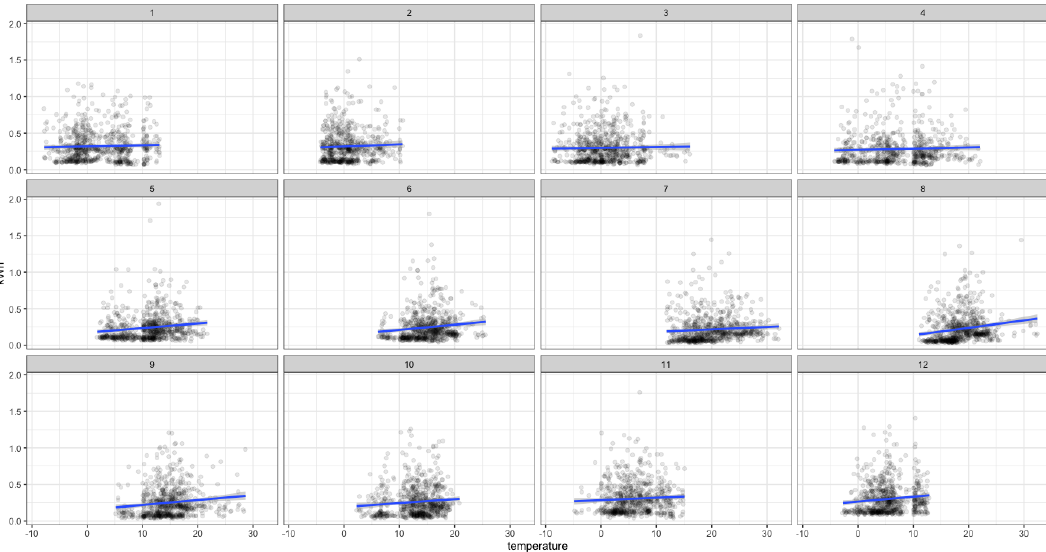
Figure 9. Consumption for smart-meter 92 vs temperature for each month of